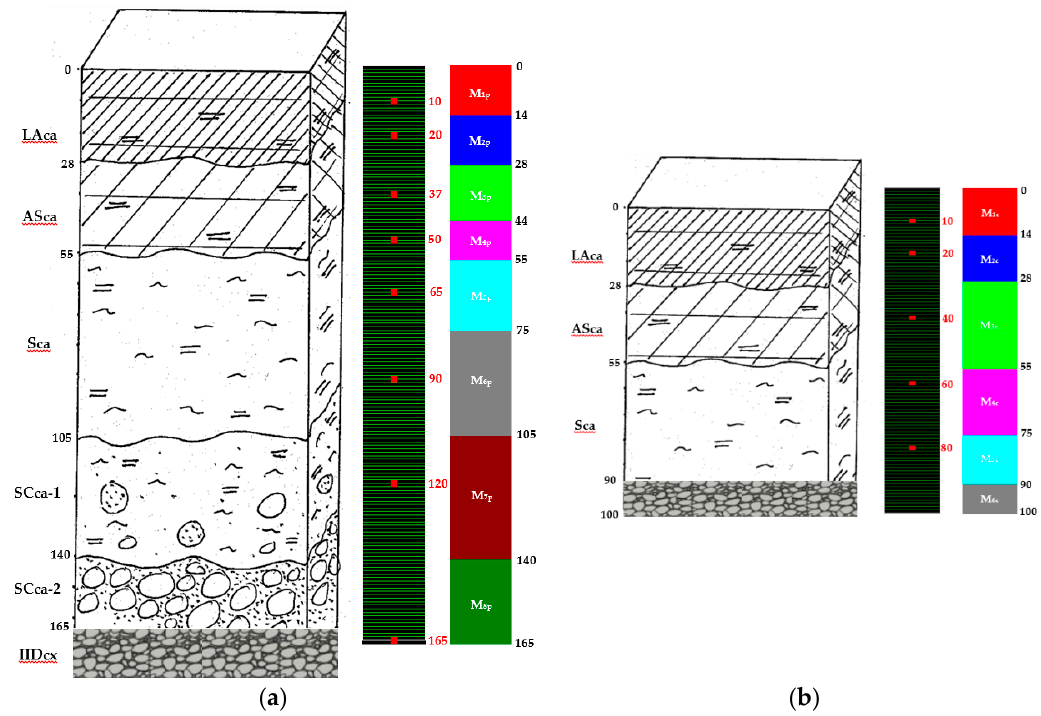
Figure 1. Field plot ( a ) and lysimeter ( b ) soil profiles: horizons, discretization, observation nodes and soil materials considered in the HYDRUS-1D model.